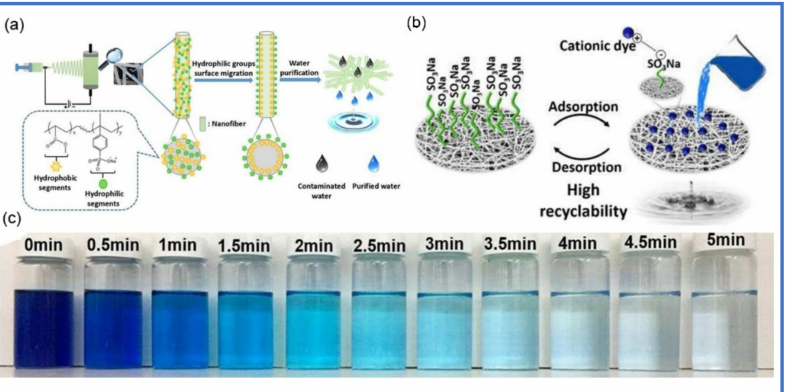
Figure 5. ( a ) Fabrication of blend PES/P(MMA-SSNa) nanofibers ( b ) migration of sulfonate groups into the surface of nanofibers and their role in interaction with MB ( c ) Photography of cationic dye (MB) color change with time after immersing nanofibers [128]. Copyright © (2020) Royal Society of Chemistry. Table 3. Pristine and blend electrospun polymer nanofibers as adsorbent for removal of dyes.